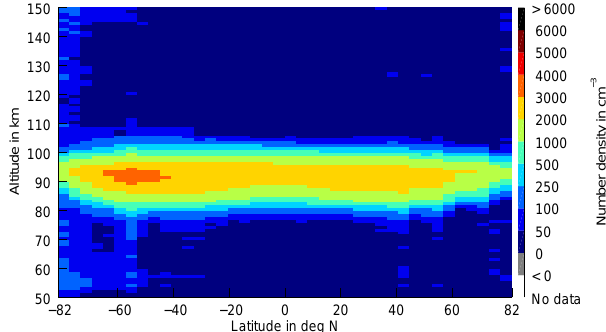
Figure 14. Annual mean Na distribution. Note that the high lati- tudes are only measured in the hemispheric